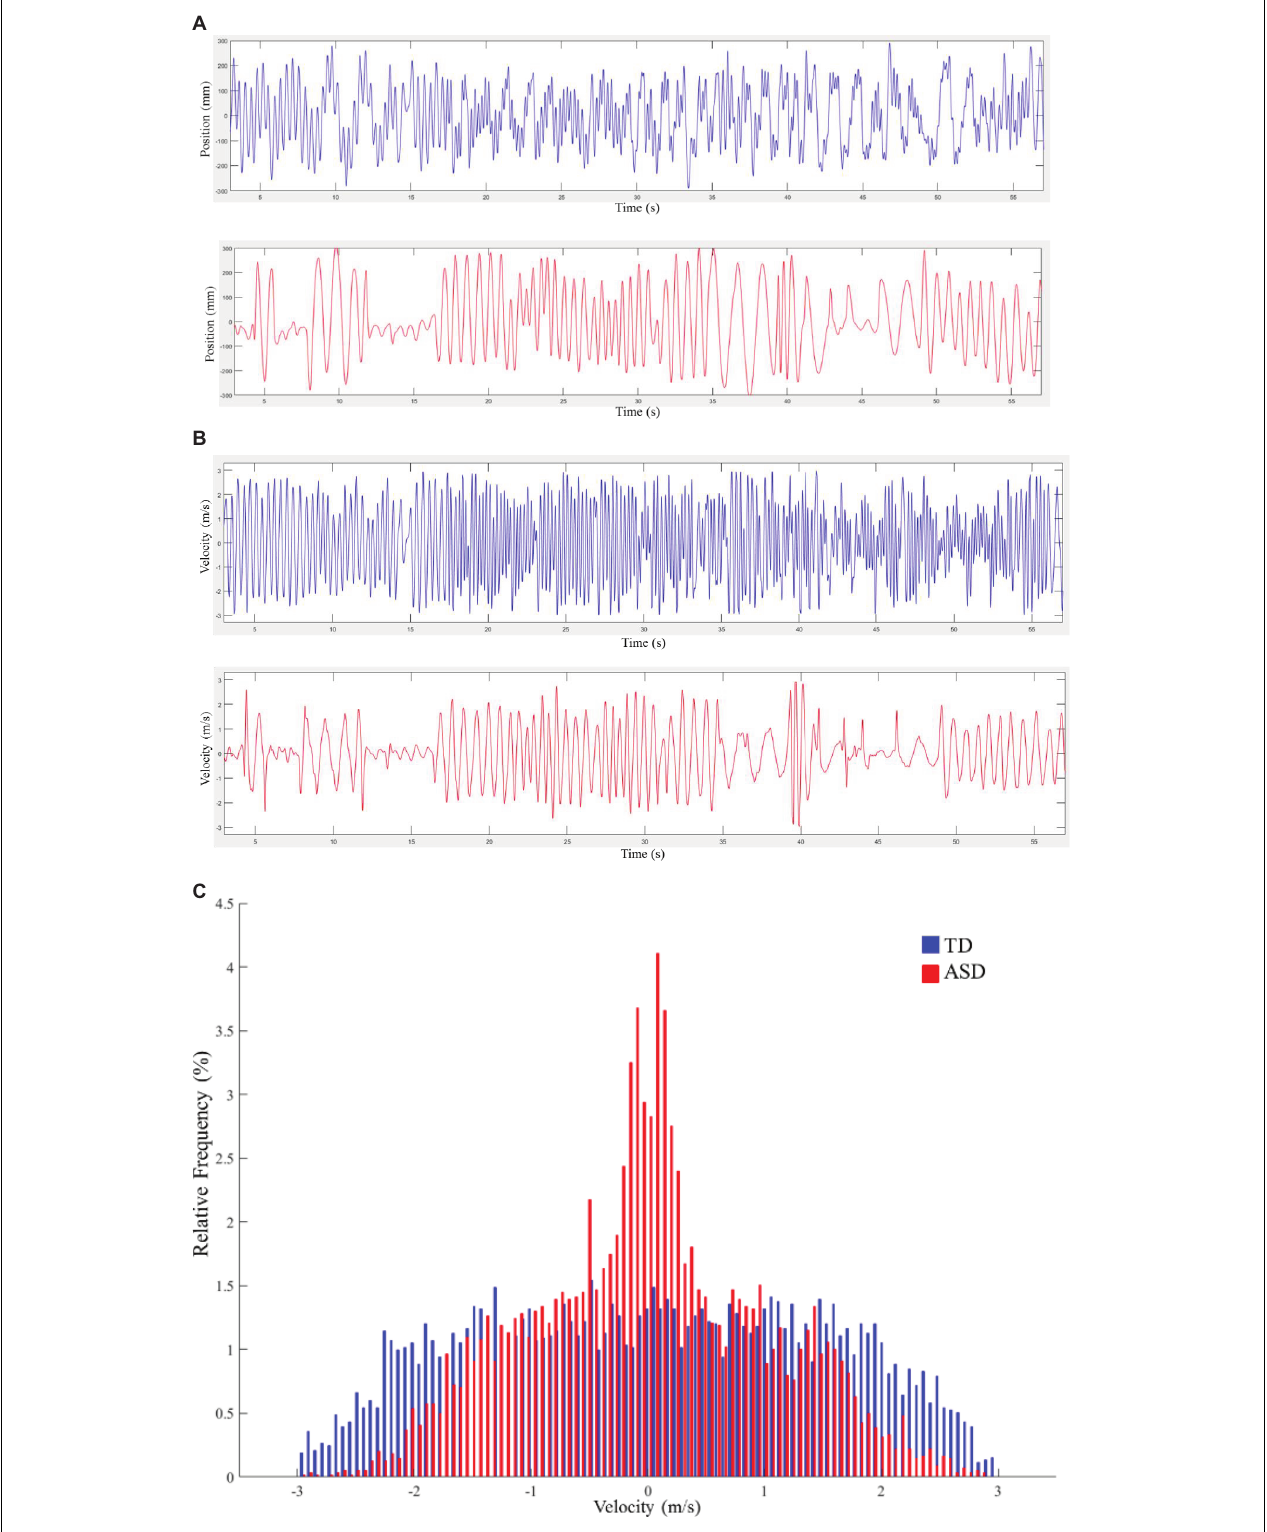
FIGURE 2 | (A) Exemplary samples of time series for the position. Typical development (TD) is plotted in blue, and autism spectrum disorder (ASD) is plotted in red. (B) Exemplary samples of time series for velocity. TD is plotted in blue, and ASD is plotted in red. (C) Velocity distributions for typical movement trials from a child with TD and a child with ASD. TD is plotted in blue, and ASD is plotted in red. Each bin in the graph represents the proportion of corresponding velocity values in the trial.